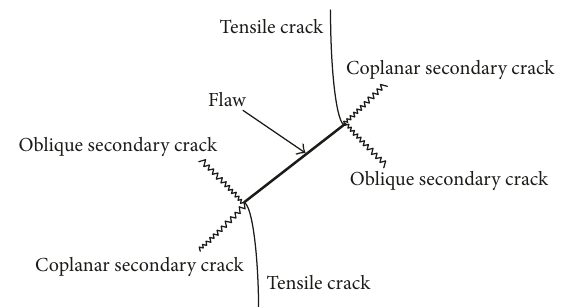
Figure 3: Crack types observed in preflawed specimens under load.